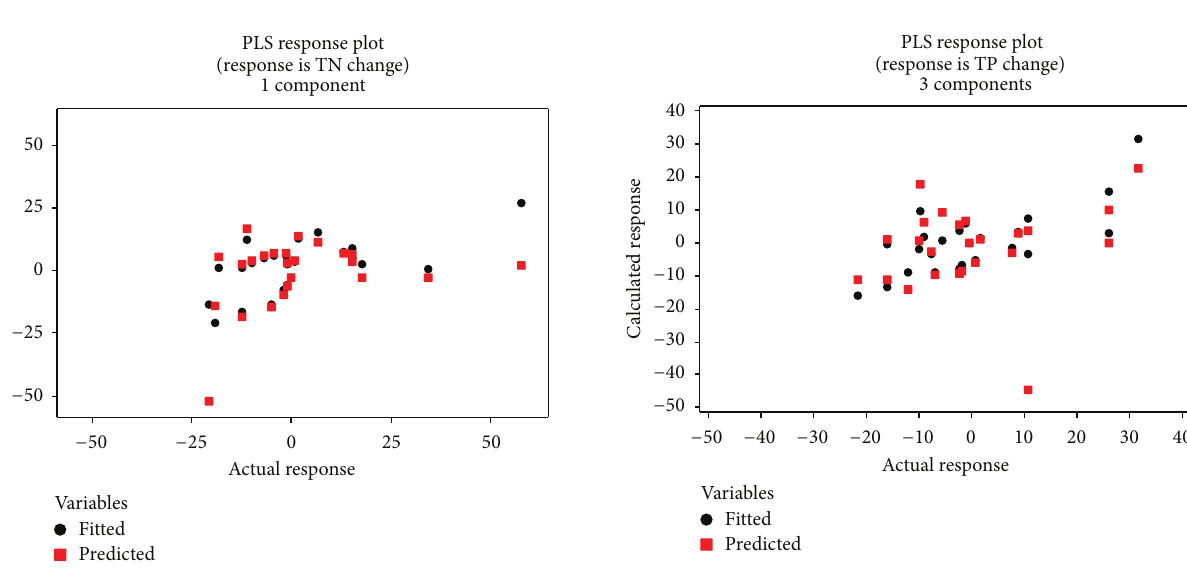
Figure 10: Scatter plot of the fitted and cross-validated data versus the actual TN changes.